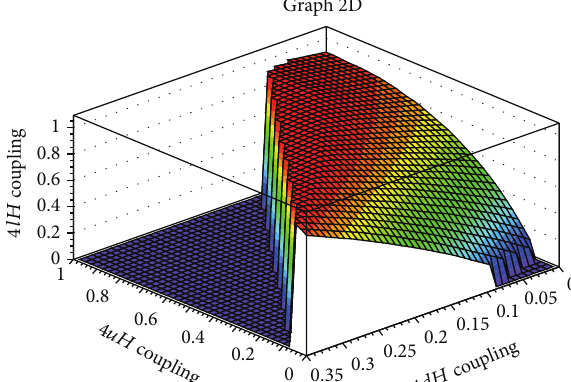
Figure 6: The dependence of the ratio 𝑅 on the suppression factors 4𝑢𝐻 and 4𝑑𝐻 of Higgs coupling to correspondingly up- and downtype fermions of the 4th generation.